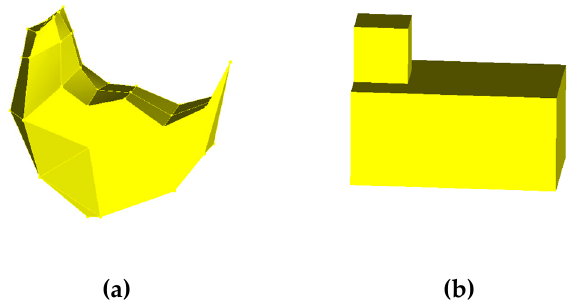
Figure 6. Schematic diagram of broiler model: ( a ) body only model, ( b )block model.